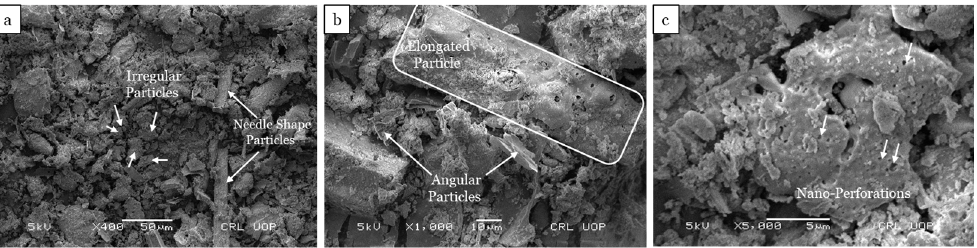
Figure 3. SEM micrographs of ground SCBA. ( a ) Irregular Particles and Needle Shape Particles; ( b ) Elongated Particle and Angular Particles; ( c ) Nano-Perforations.